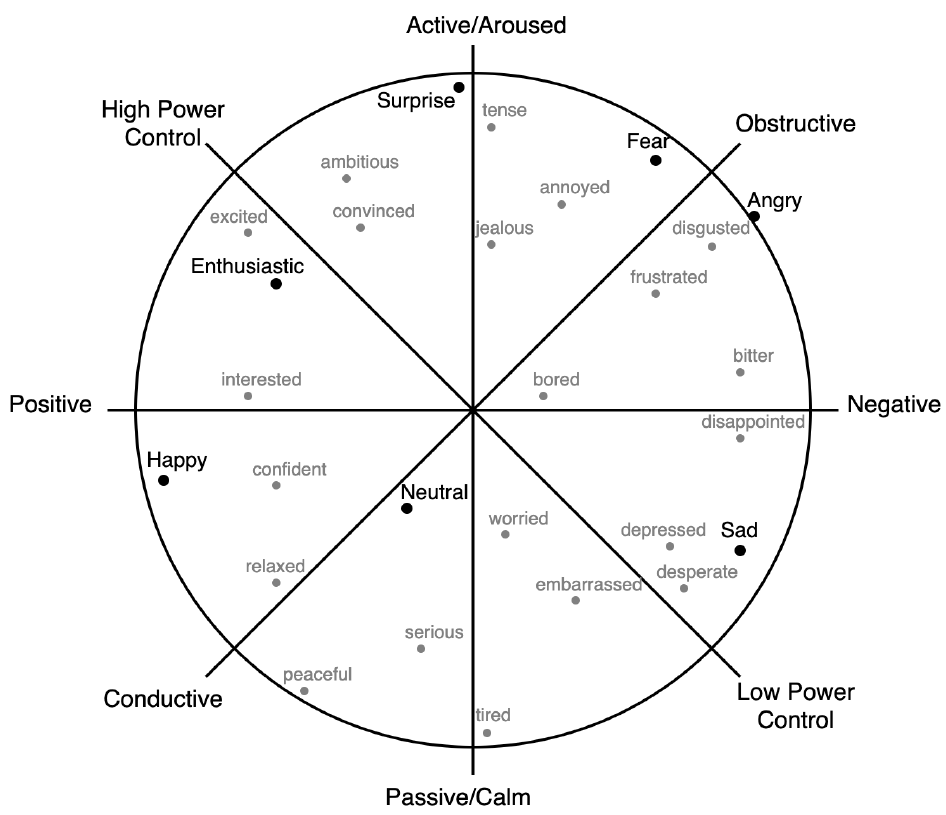
Figure 1. Illustration of Scherer’s circumplex [52], which shows categories represented by the dimensions arousal and